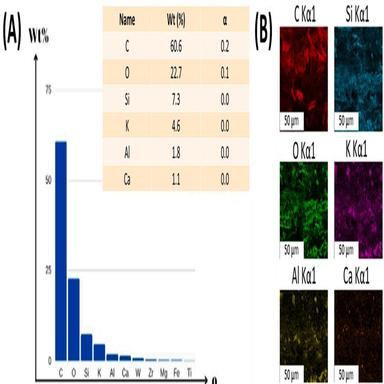
(A) Elemental mass percentage and (B) elemental mapping of activated carbon material activated under an inert N2 atmosphere at 700 ◦C.